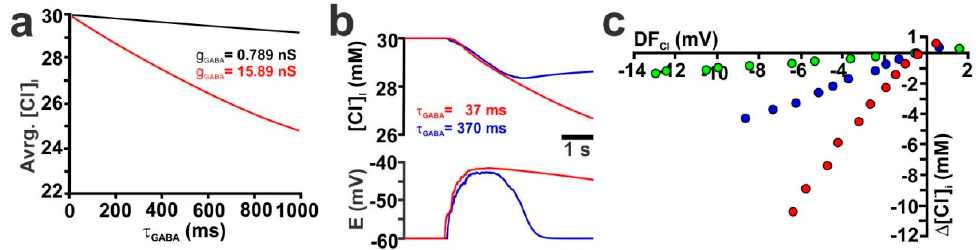
Figure 4. Influence of the decay time constant of GABA receptors ( τ GABA ) on GABA-induced [Cl ⁻ ] i transients. ( a ) Relationship between average [Cl ⁻ ] i and τ GABA at g GABA of 0.789 nS (black trace) or 15.78 nS (red trace) upon a single synaptic stimulation (P HCO3 = 0, [Cl ⁻ ] i = 30 mM) in an isolated dendrite. ( b ) GDP-induced average [Cl ⁻ ] i and E m changes (n GABA = 302, g GABA = 0.789 nS, P HCO3 = 0) using τ GABA of 37 ms (red trace) and 370 ms (blue trace) in a reconstructed CA3 pyramidal neuron. ( c ) Relationship between DF Cl and the GDP-induced [Cl ⁻ ] i transients obtained with different τ GABA of 3.7 ms (green), 37 ms (blue) and 370 ms (red).